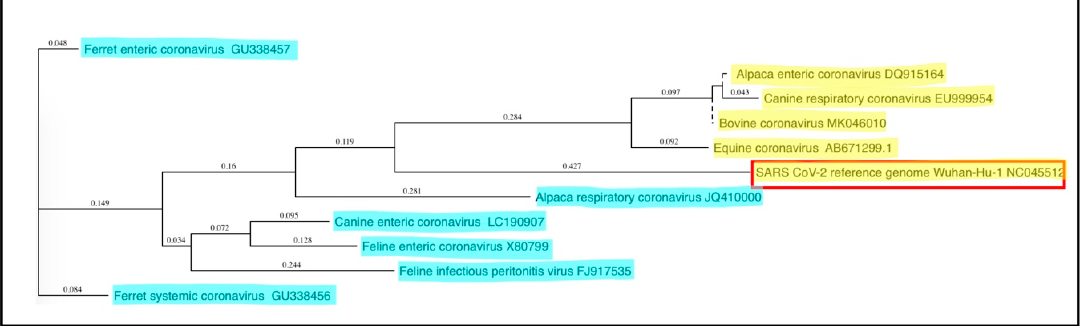
Figure 1. Phylogenetic relationships of coronaviruses of companion animals. The 3 ′ portions of the coronaviral genomes encoding the spike and other non-structural proteins (~9 kb) were compared and plotted as a “guide tree” using MacVector software (ClustalW Multiple Sequence Alignment). Betacoronavirus sequences are highlighted in yellow, while alphacoronavirus sequences are highlighted in blue; the zoonotic SARS CoV-2 coronavirus is surrounded by a red box. GenBank submission numbers are indicated for each sequence.